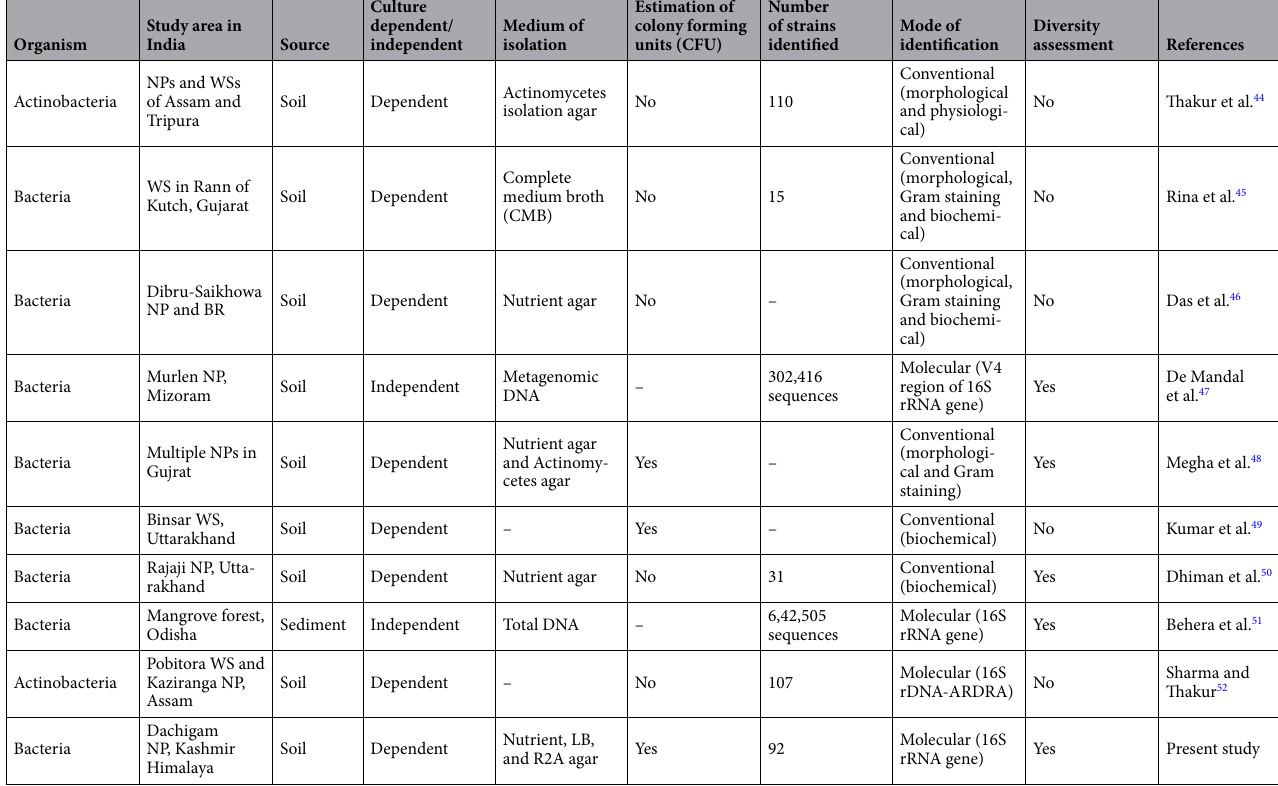
Table 1. Studies conducted on bacteria isolated from different soil and sediment samples in various protected areas of India. NP National Park, WS Wildlife Sanctuary, BR Biosphere